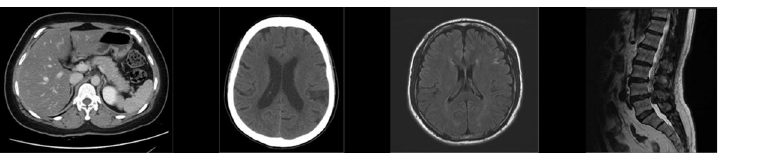
Fig 1. Example image of each modality and anatomical location. (a) abdomen CT, (b) brain CT, (C) brain MRI, (d) MRI lumbar spine.